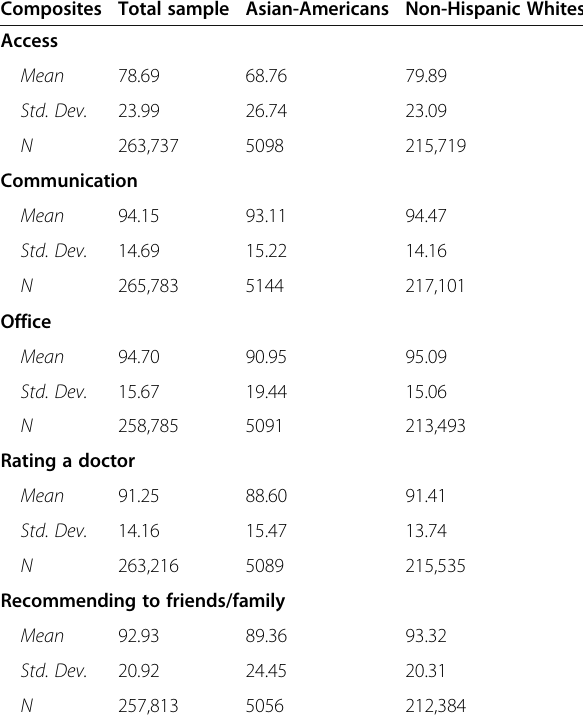
Table 3 Means and standard deviations for the five dependent variables in the CAHPS clinician and group adult visit survey